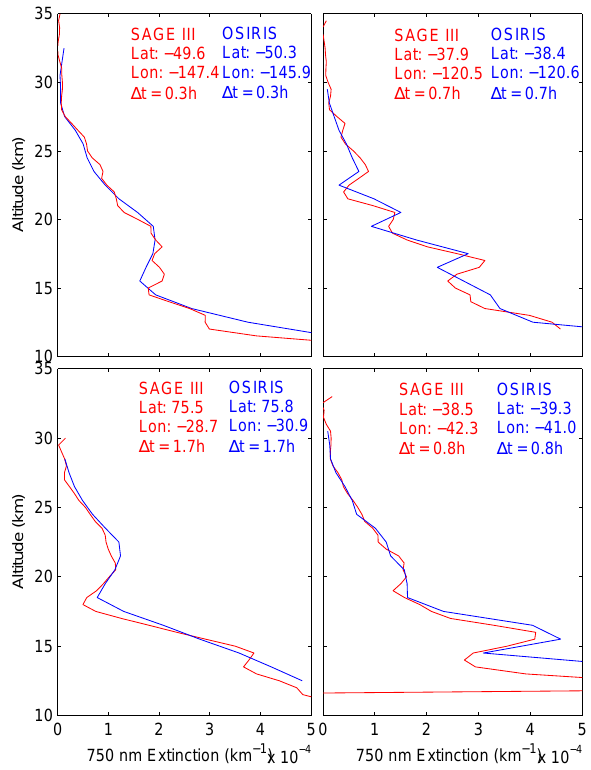
Fig. 3. Four coincident SAGE III and OSIRIS aerosol extinction coefficient measurements. SAGE III measurements at 755nm are shown in red and OSIRIS measurements at 750nm are shown in blue. The latitude, longitude of each measurement and the time dif- ference between each coincident SAGE III and OSIRIS measure- ment are given in each corresponding